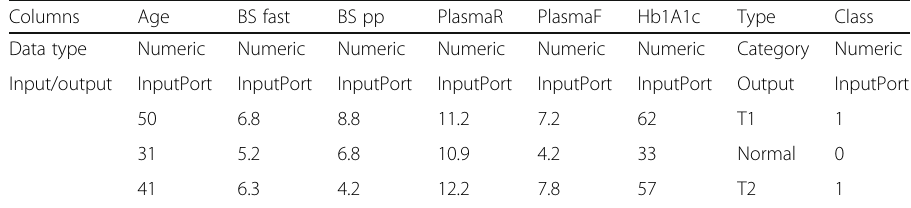
Table 4 Data preprocessing: mapping